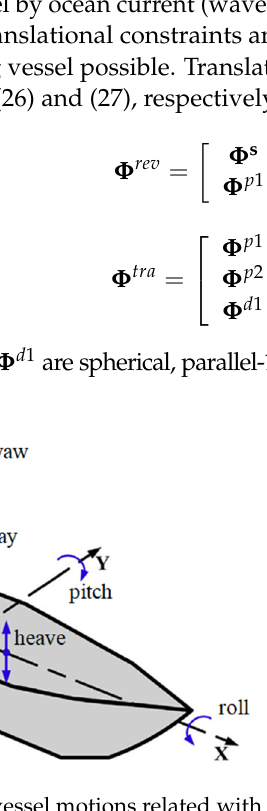
Figure 11. Six-directional vessel motions related with kinematic constraints.